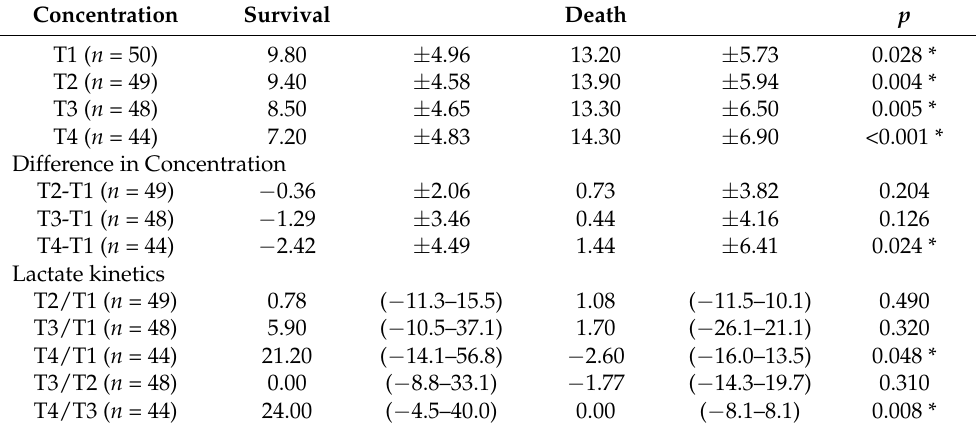
Table 2. Changes in lactate concentrations and kinetics in arterial blood gas from T1 to T4 time points. Concentration